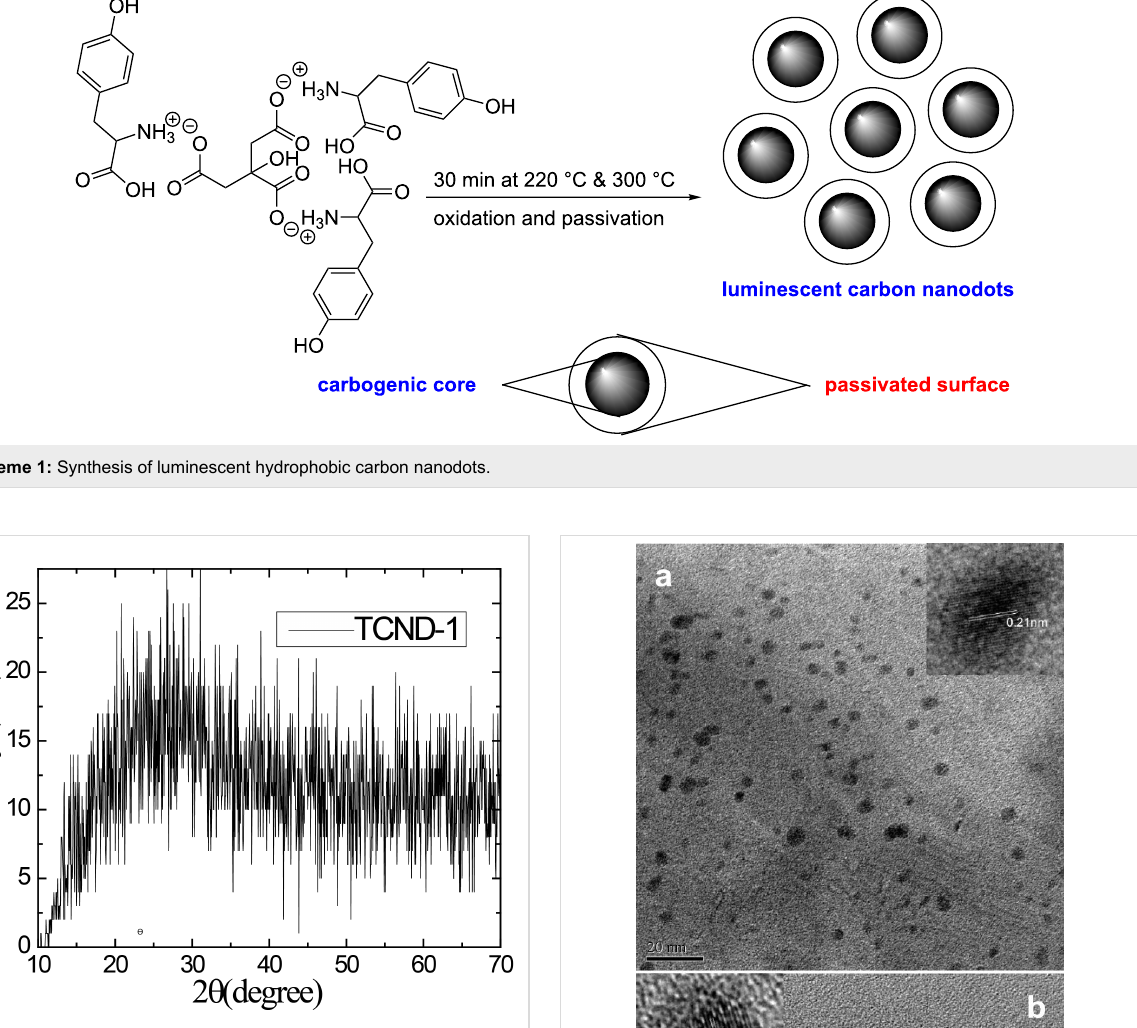
were assigned to the stretching bands of aromatic carbon atoms (-C=C-), the strong signal at about 1517 cm − 1 was attributed to a combination of a C–N stretching band and a N–H